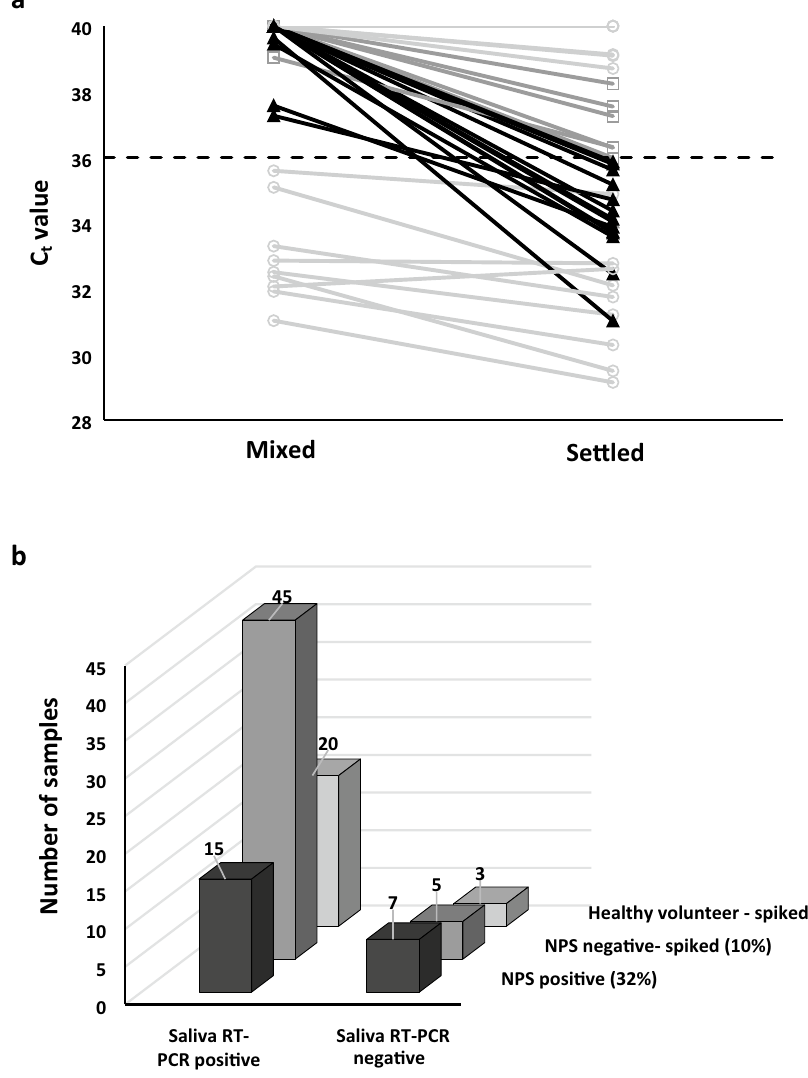
Figure 1. Detection of SARS-CoV-2 in minimally processed saliva samples from COVID-19 positive and negative volunteers. ( a ) Improved detection of spiked saliva samples allowed to settle after processing versus being mixed after processing. Solid black triangles represent samples that became detectable (C t < 36) after settling; dark grey open squares represent samples that showed improved C t values but remained above the cut-off C t value (C t > 36, black dashed line); light grey open circles represent samples that were either detectable in both groups or did not show an appreciable change in C t value. A C t value of 40 represents a negative result. ( b ) Prevalence of false negative SARS-CoV-2 RT-PCR outcomes using minimally processed saliva samples. The sample number is indicated above the data columns. The percent of false negatives is shown in brackets beside each group. All NPS positive saliva samples were tested as is. All NPS negative and healthy volunteer saliva samples were spiked with 10 6 genome copies/mL heat-inactivated SARS-CoV-2 prior to testing. All samples tested at least in triplicate. See Supplementary Fig. S2 for individual sample C t